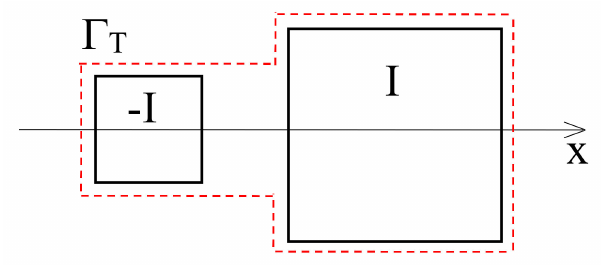
Figure 10. Non-symmetric two-wire transmission